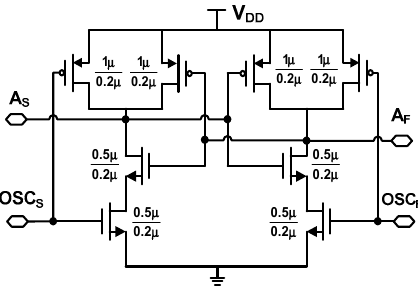
Figure 10. Schematic of the arbiter.